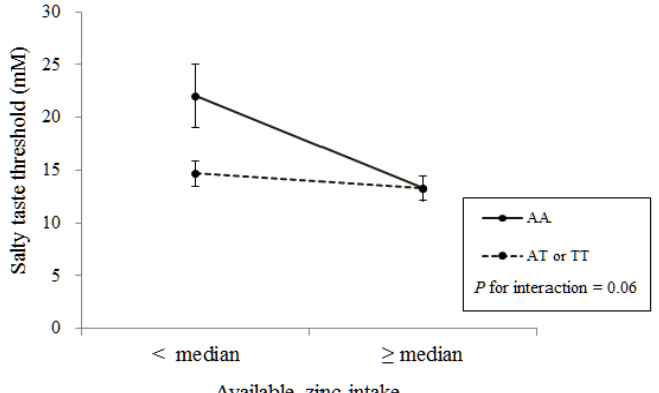
Figure 2. The joining effects of α ENaC A663T genotypes and available zinc intake on salty taste threshold in